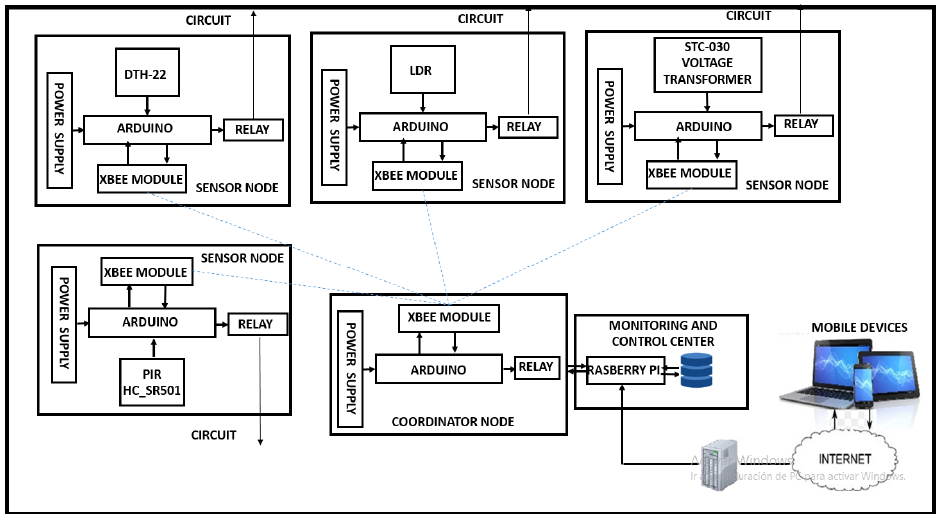
Figure 4. Complete System Architecture.